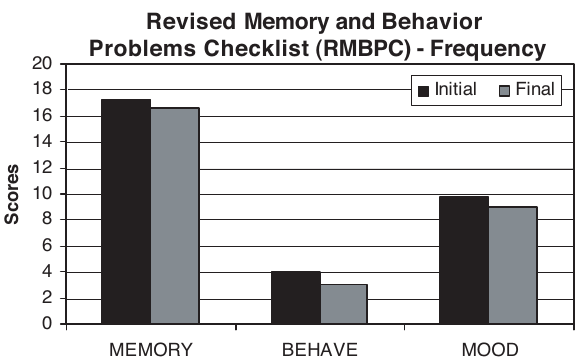
Figure 1. Shows RMBPC frequency scores between initial and second evaluation. We were unable to detect statistical difference between evaluations on observed frequencies: memory (Z=0.314, p=0.753), behaviol (Z= –0.716, p=0.474), mood (Z= –0.401, p=0.688). Fre- quency of symptoms on RMBPC.